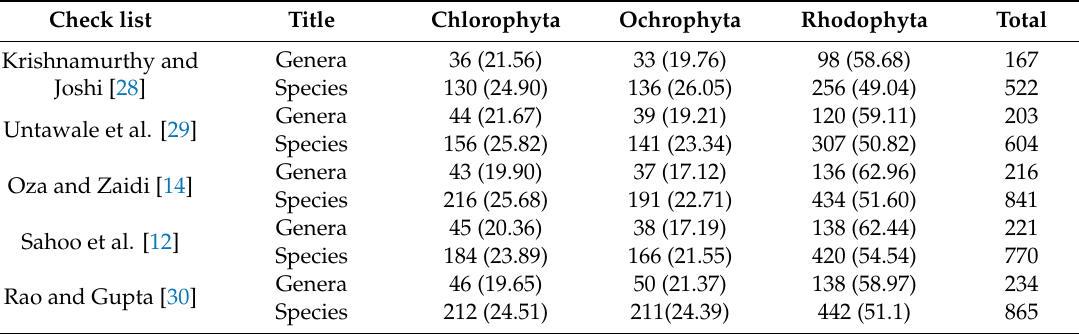
Table 2. The comparison of seaweed records reported by earlier